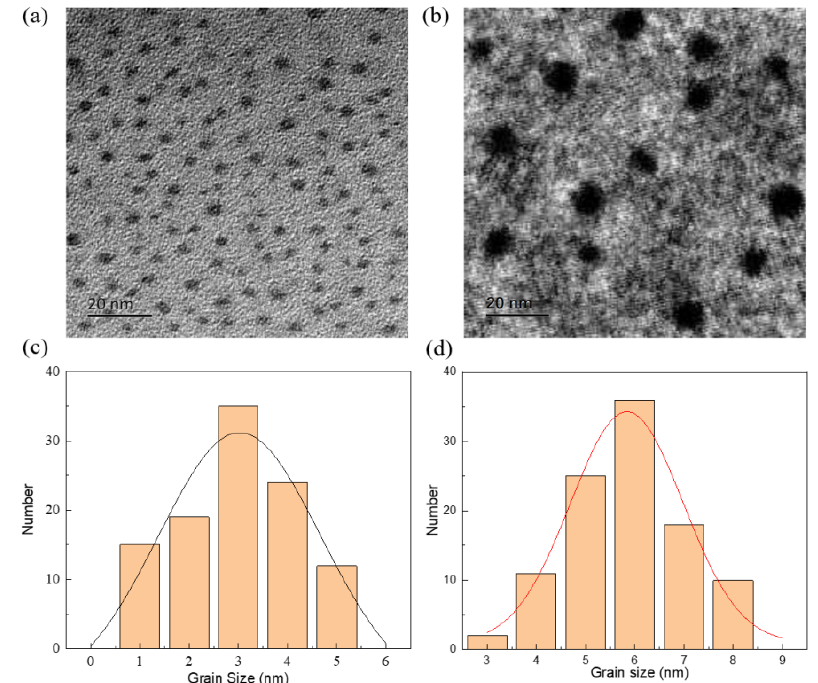
Figure 2. TEM images and distribution of grain size of pure CsPbBr 3 QDs ( a , c ) and SBA-15@CsPbBr 3 QDs ( b , d ).